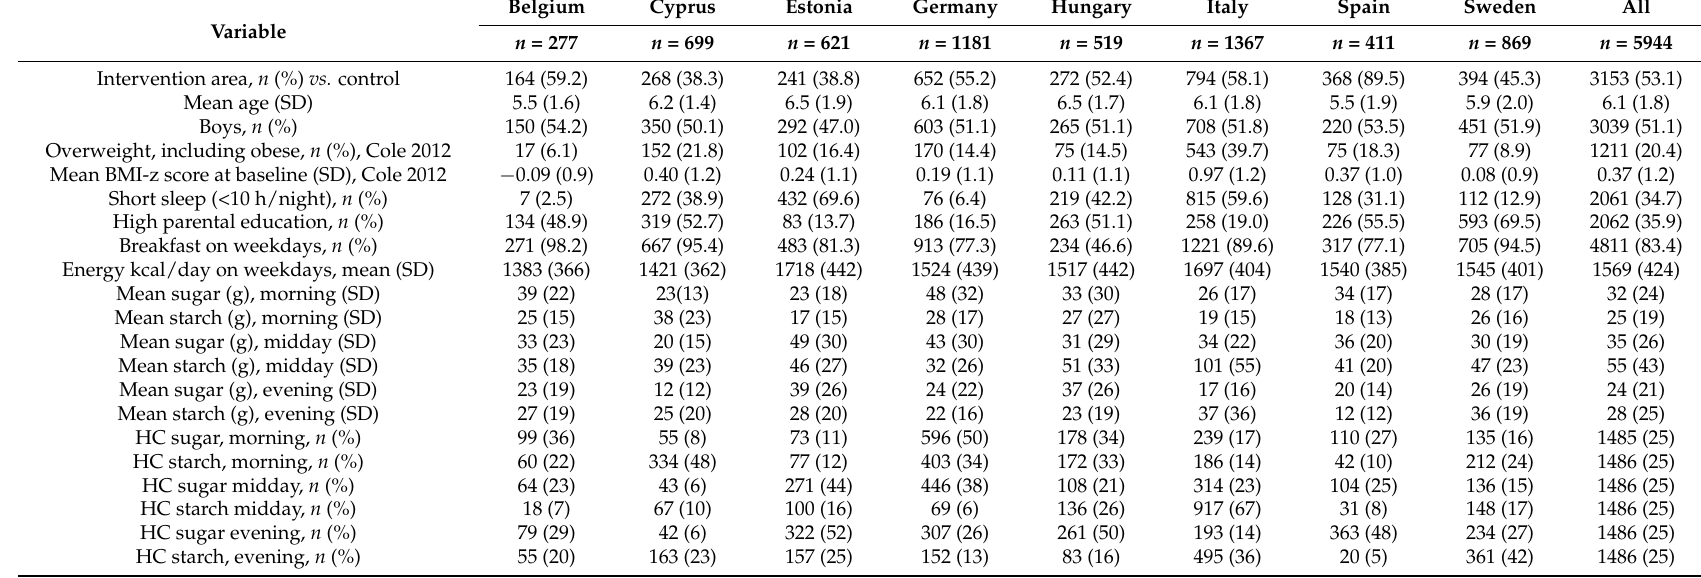
Table 1. Characteristics of the study sample and distribution of covariates by country at baseline